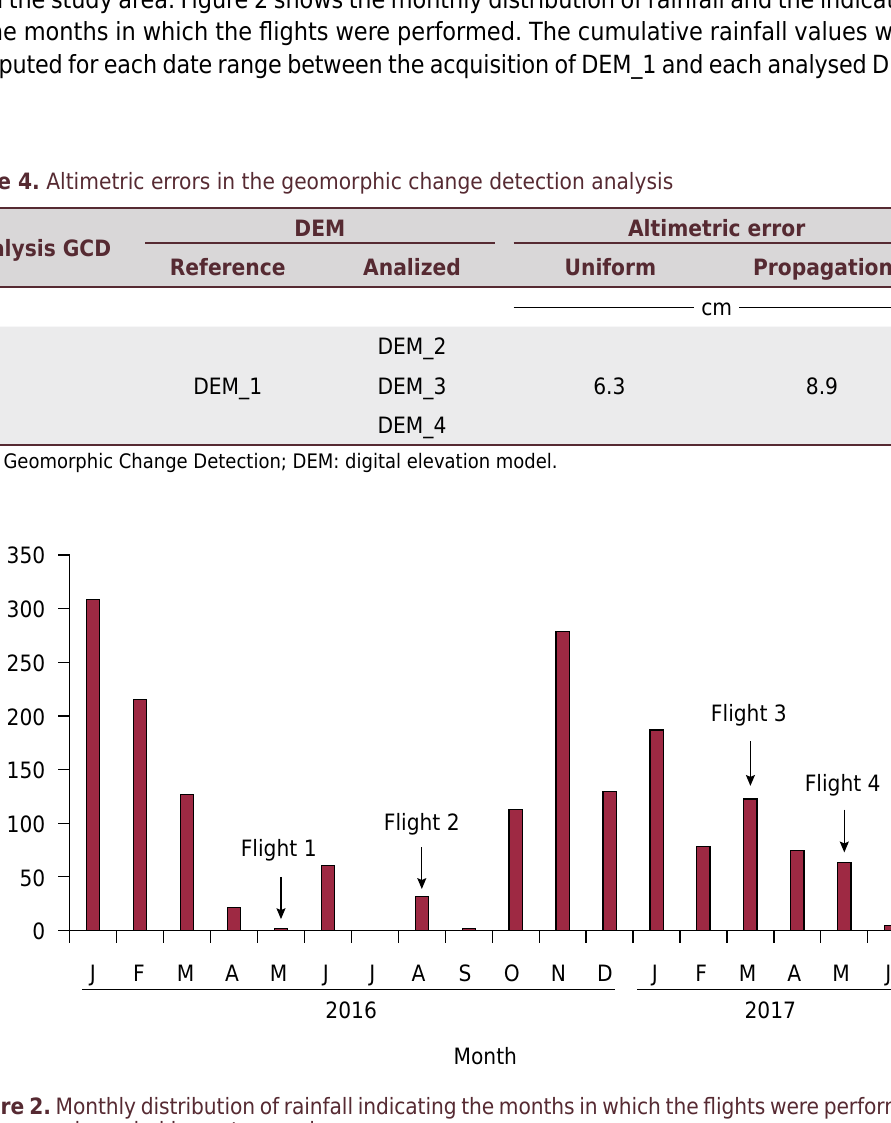
Figure 2. Monthly distribution of rainfall indicating the months in which the flights were performed in the area degraded by water